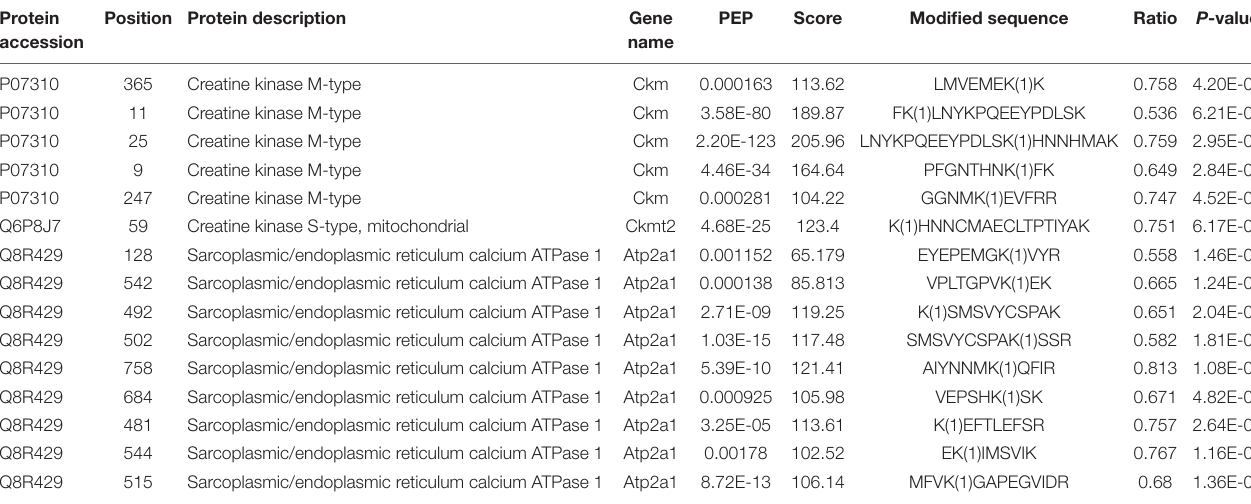
TABLE 4 | Deacetylated sites of Ckm, Ckmt2, and Atp2a1 after exercise. Protein Position Protein accession